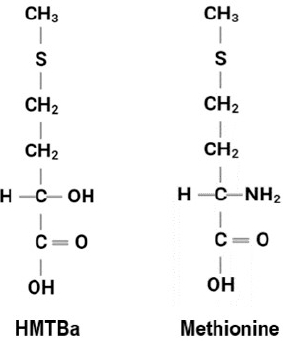
Figure 1. Comparison of chemical structures of HMTBa (methionine hydroxy analogue) and amino acid methionine.